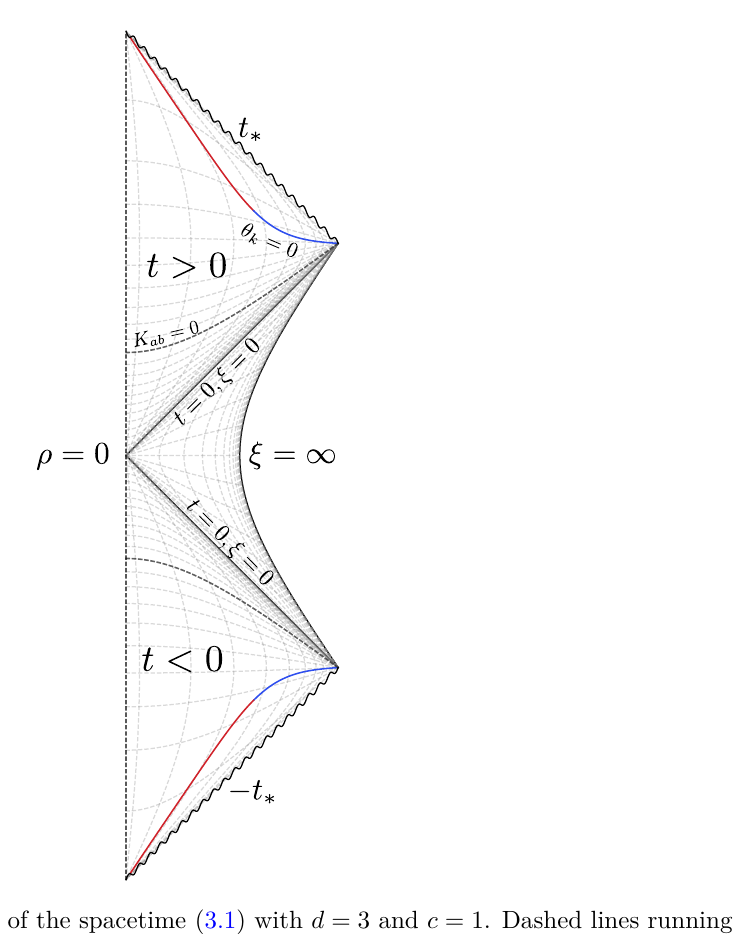
Figure 2. Conformal diagram of the spacetime (3.1) with d = 3 and c = 1 . Dashed lines running vertically are hypersurfaces of constant ρ and ξ , with equidistant coordinate spacing. Dashed lines running horizontally are hypersurfaces of constant t and ζ , with equidistant coordinate spacing. The blue line is the spacelike section of a holographic screen, while the red line is the timelike portion. The darker horizontal dashed lines are the constant − t surfaces at which the FRW region transitions between expanding and crunching ( a 0 ( t ) = 0 ), which are totally geodesic. These are extremal surface